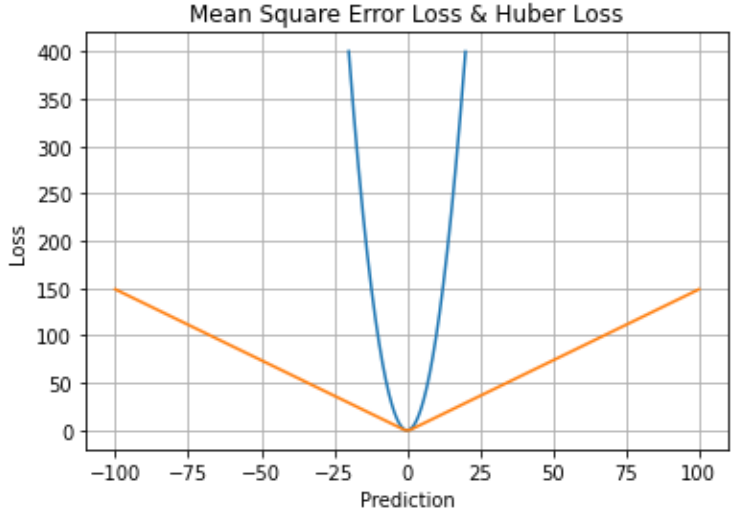
Figure 7. Mean Square Error Loss & Huber loss.